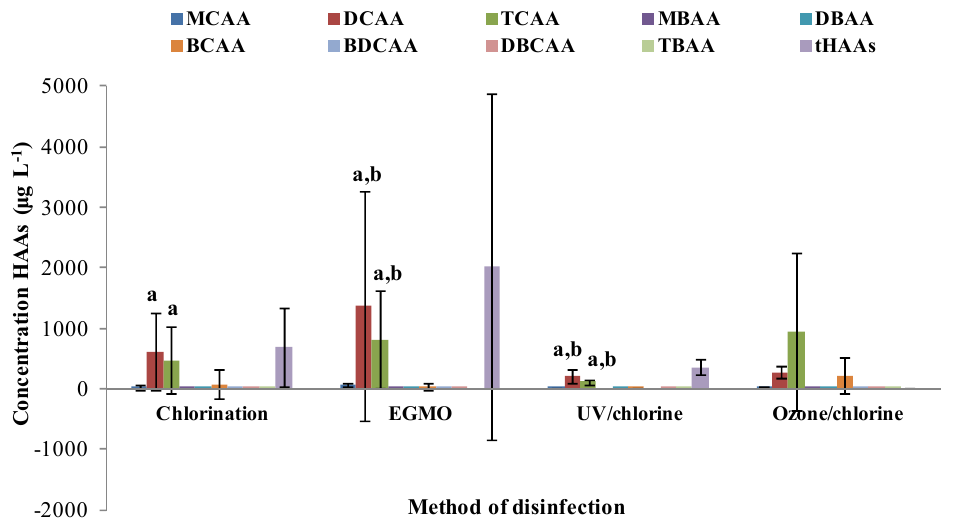
Figure 2. Mean and standard deviation of HAAs with different methods of disinfection. Note: “ a ” shows that chlorination, EGMO and UV/chlorine are not significantly different from each other; ” b “ shows that UV/chlorine is significantly different from EGMO at α = 0.05 ( p < 0.05). Statistical analysis to compare the means in the case of ozone/chlorine was not carried out because of fewer data points.